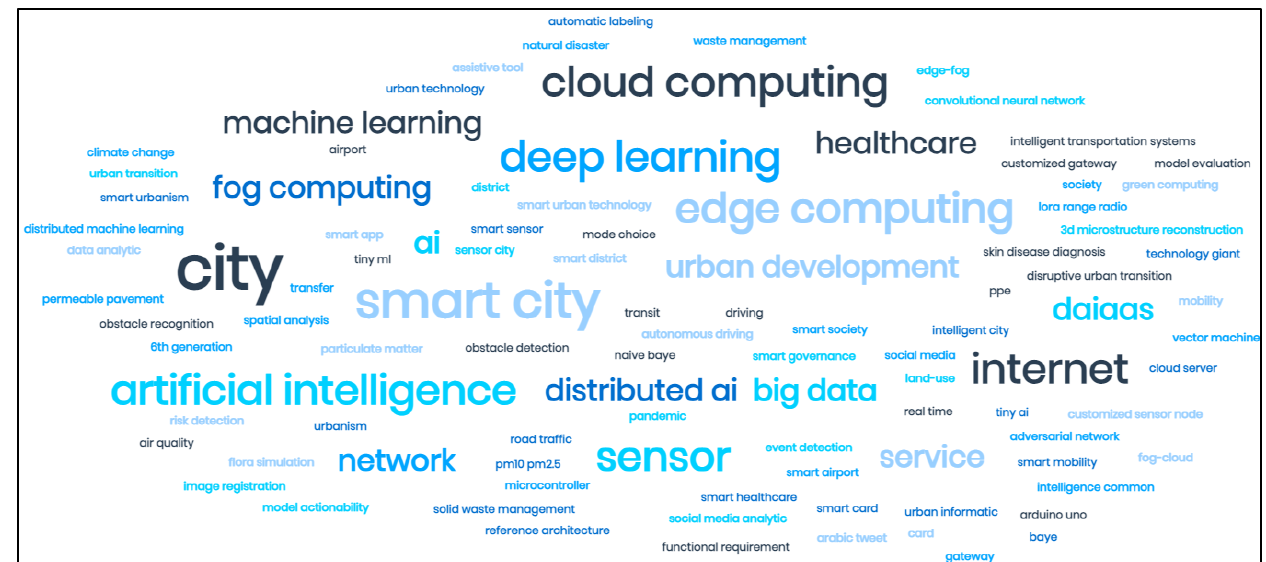
Figure 1. A Word Cloud of the Research Topics in this Special Issue.